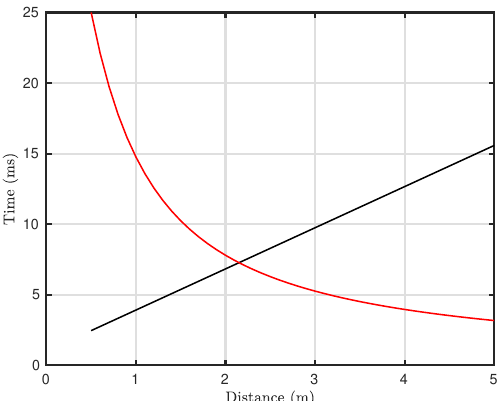
Figure 7. Critical distance shown as the intersection between the pulse period (on time plus guard, black curve) and the maximum allowed period given the object’s projected height (red curve). The curves correspond to both sides of the inequality in Equation (6) divided by f frame · N y resulting in time units. γ = 1, T guard = 1ms, H = 1 m, f frame = 60fps, and FOV v = π